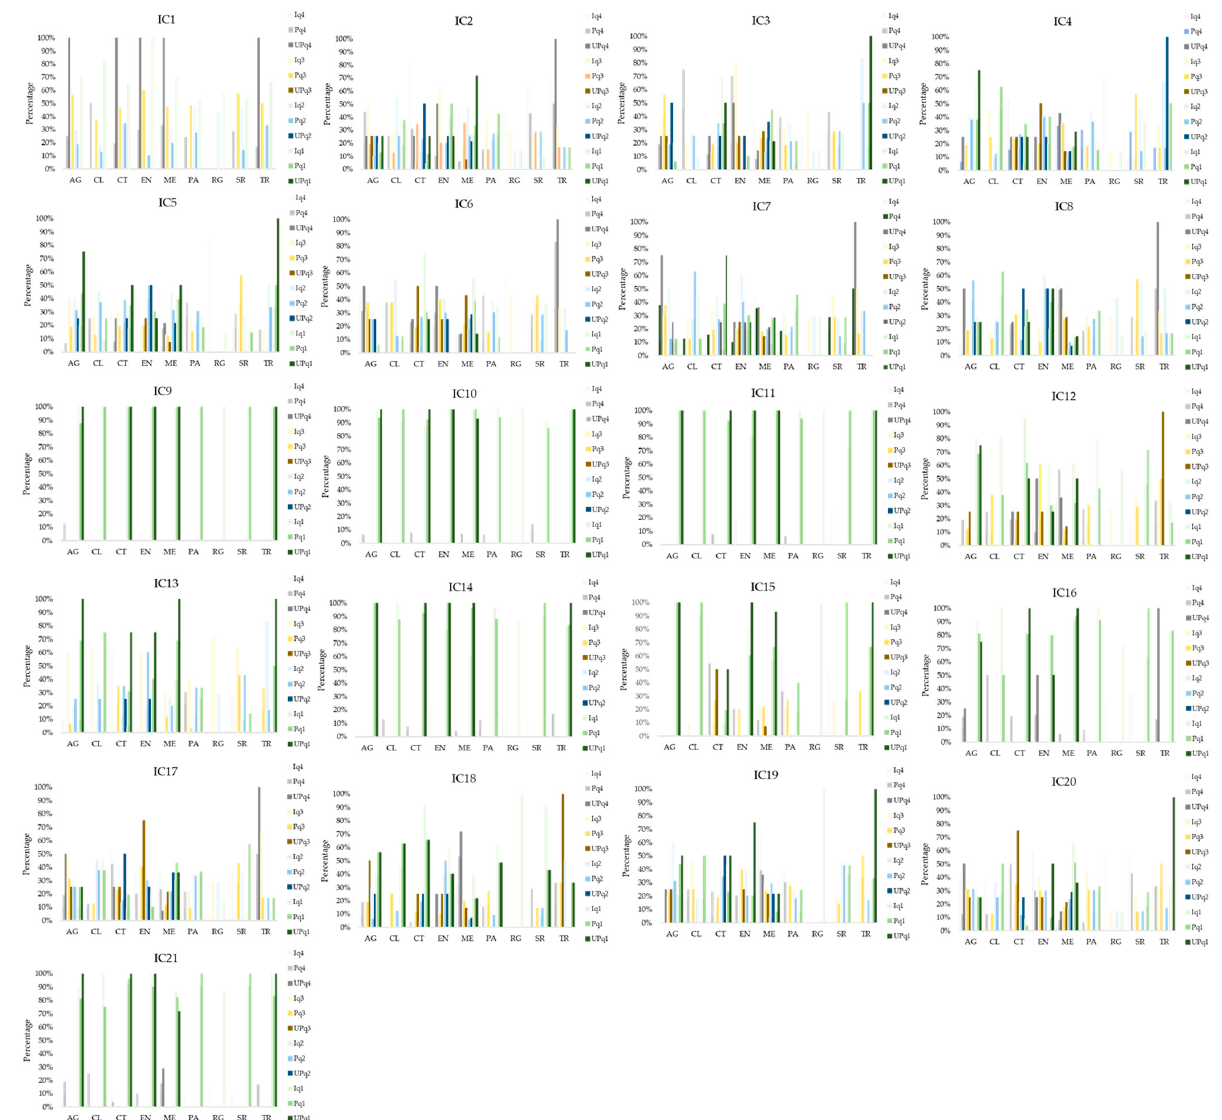
Figure A3. Comparison of the percentages of municipalities for different metropolitan cities in Sicily based on the quartiles of indicators for infrastructural capital, and the NSIA classification. (Authors’ elaboration).